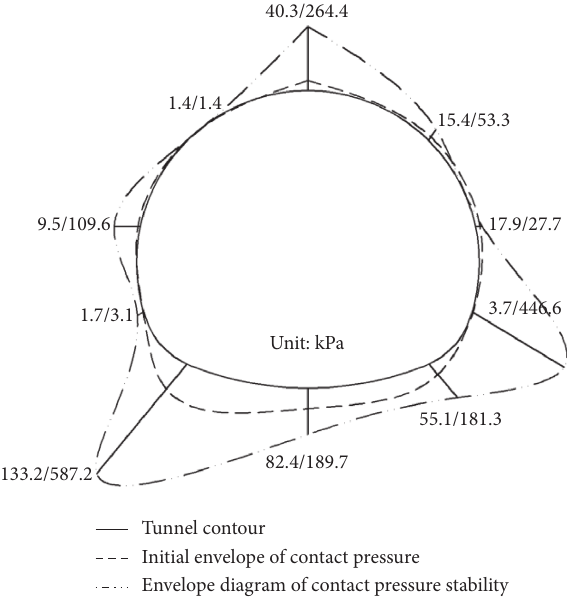
Figure 8: DK-190+645 mileage surrounding rock pressure en- velope diagram of Zaosheng